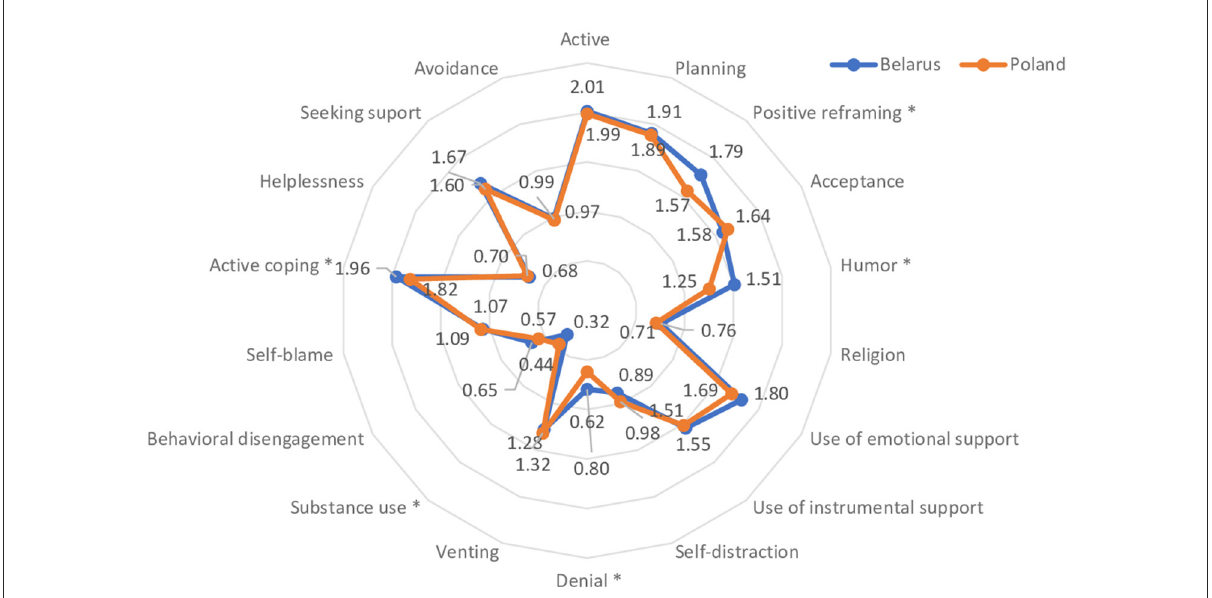
TABLE 5 Results of the rating choice of strategies for coping with perceived stress (with gender inclusion) (M ± SD). Coping-strategy BY PL Total sample Significant